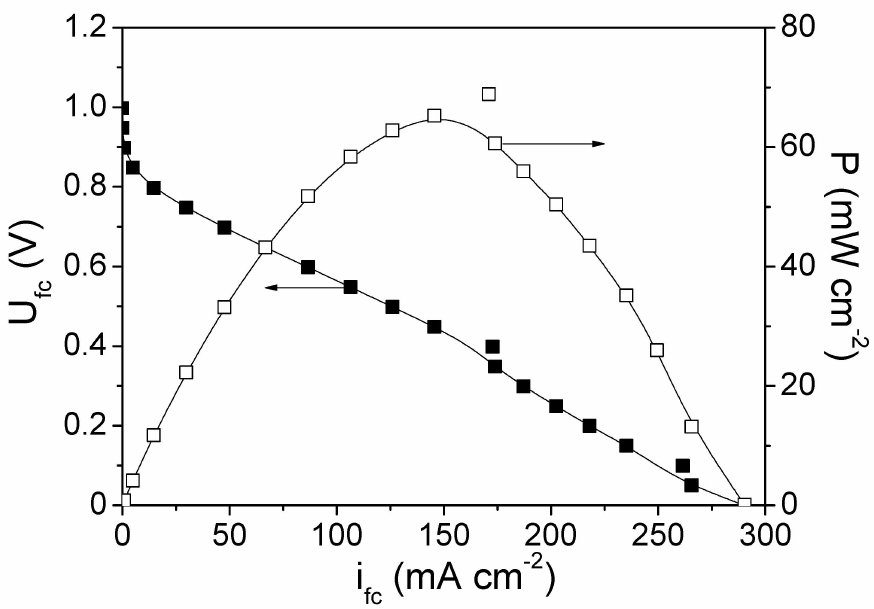
Figure 6. Cell potential ( U fc ) vs. current density ( i fc ) and power density ( P ) vs. current density ( i fc ) curves obtained for the PEMFC with the 29Pt (TKK) cathode electrode; Flow rates: F anode (100% H 2 ) = F cathode (synthetic air) = 100 cm 3 min − 1 ; geometric electrode surface area, A elec = 5.29 cm 2